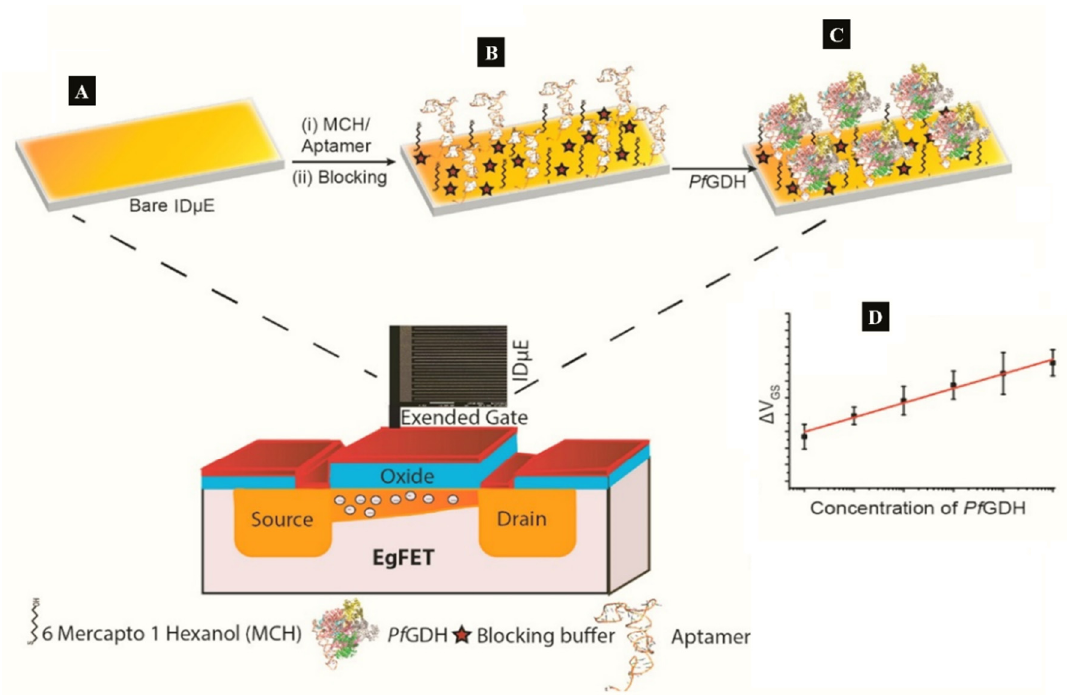
Figure 5. ( A – C ) Strategy for the label free aptaFET and (D) calibration curves obtained for PfGDH detection in serum. (Adapted from Singh et al. [49] with permission from Elsevier).